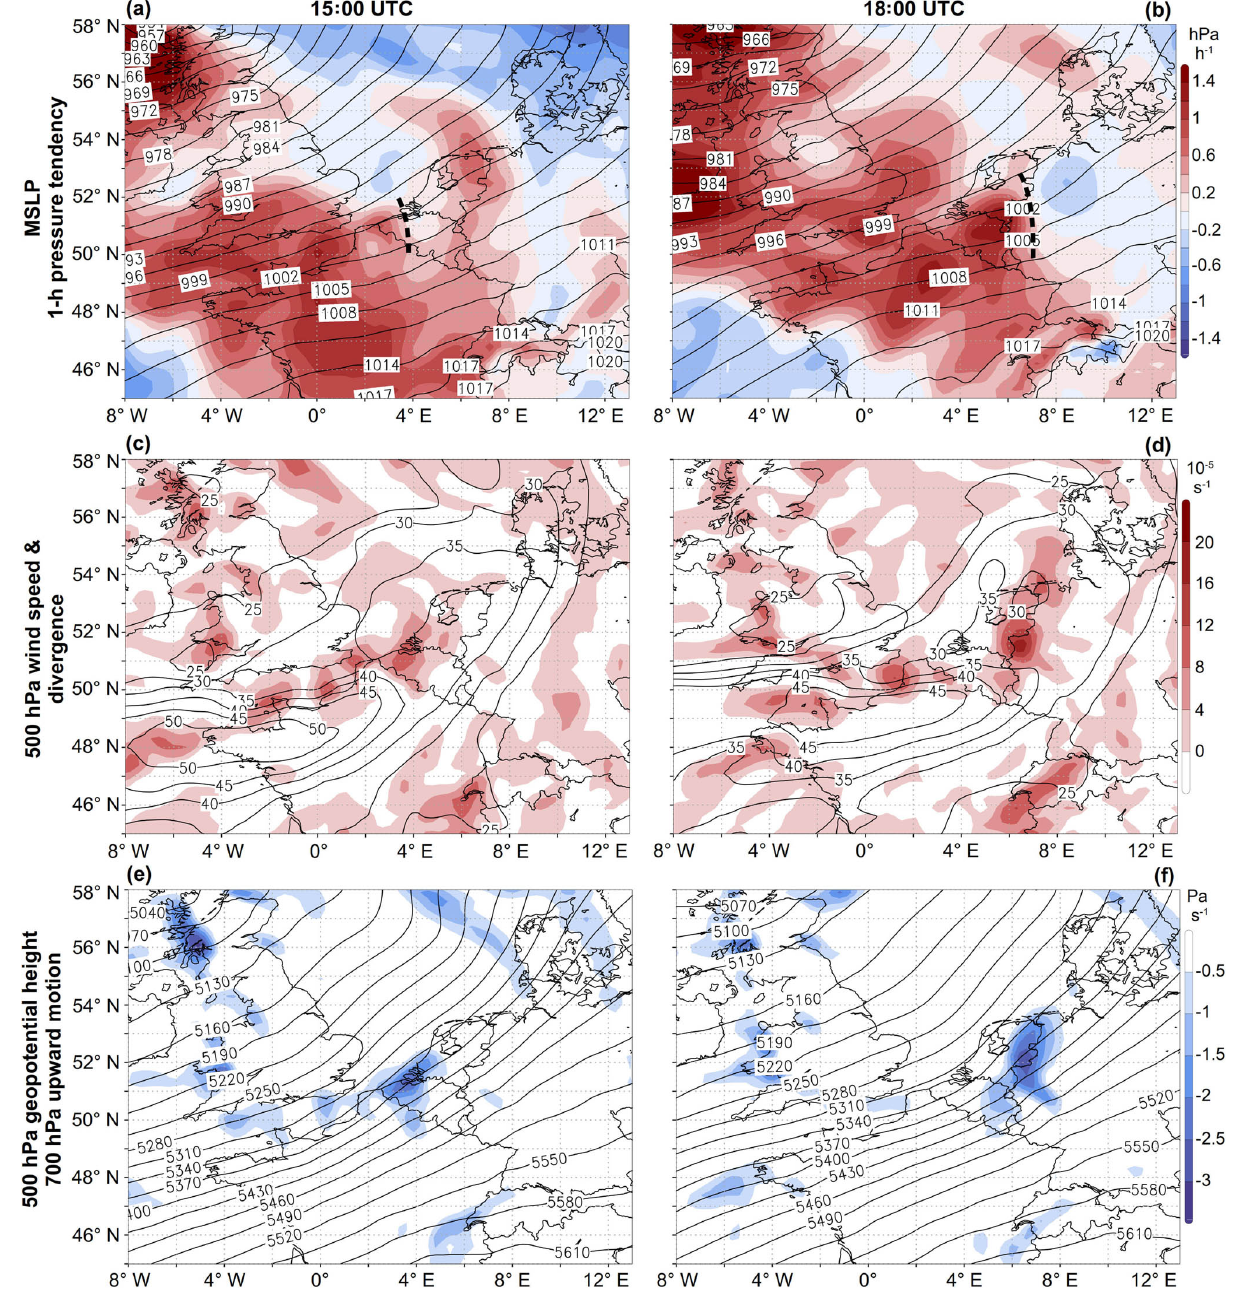
Figure 4. ERA5 reanalysis of the synoptic-scale conditions at 15:00 and 18:00UTC on 3 January 2014. (a–b) Mean sea level pressure (hPa; black lines) and hourly pressure tendency (hPah − 1 ; shaded), (c–d) 500hPa wind speed (ms − 1 ; contour lines starting at 25ms − 1 ) and divergence (10 − 5 s − 1 ; shaded), (e–f) 500hPa geopotential height (gpm; black lines) and diagnosed 700hPa upward motion (Pas − 1 ; shaded). The dashed black line in (a) and (b) denotes the surface pressure